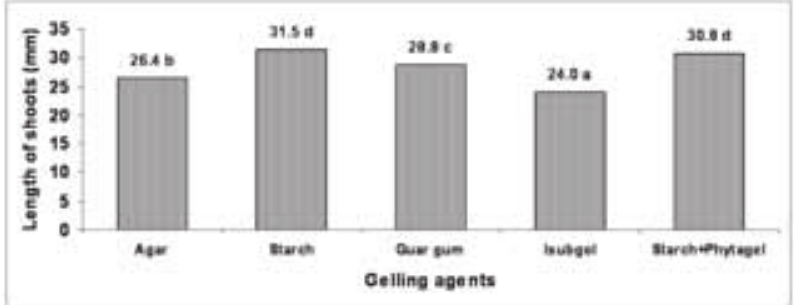
Figure 2 . The effect of the gelling agents on the shoot length (mm). Signifi cant differences ( P ≤ 0.05) between the media gelled by different gelling agents are indicated by different letters.